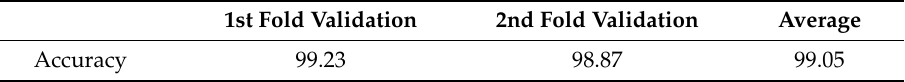
Figure 22. Various head pose image pairs selected from CAVE-DB. Table 10. Classification accuracy of frontal face image using shallow CNN (unit: %).